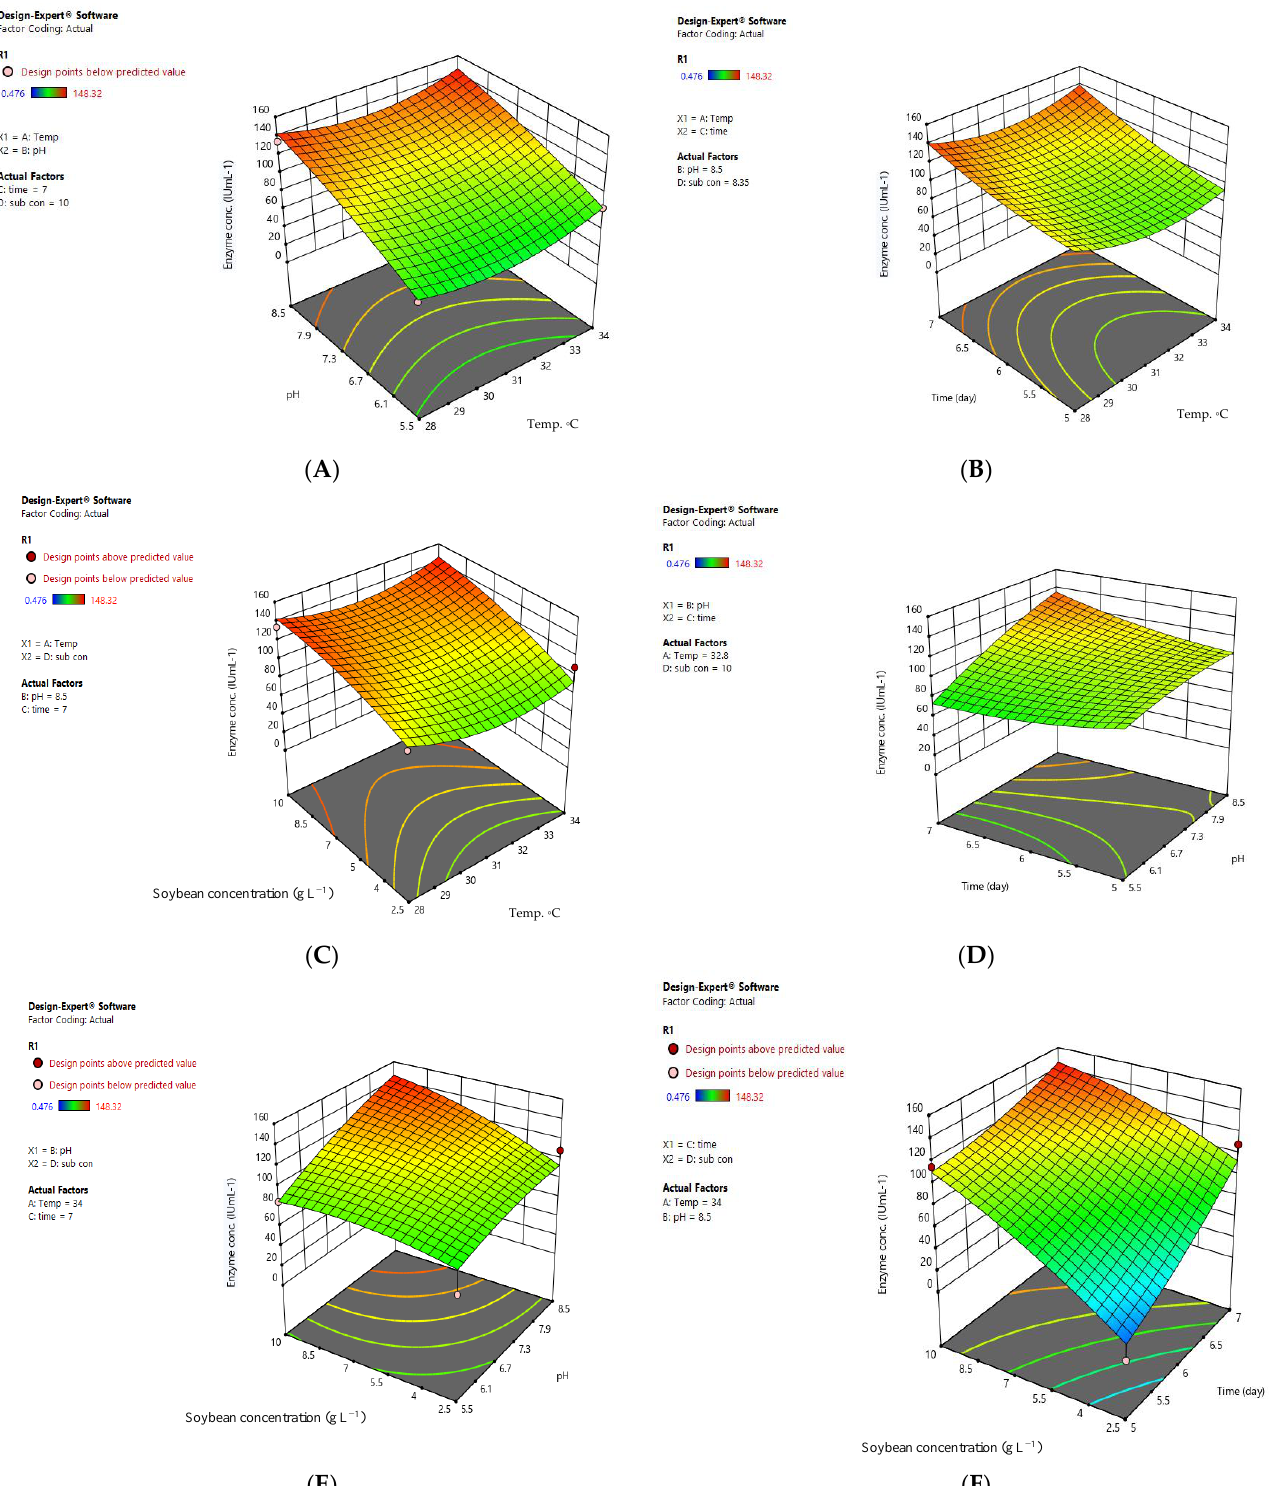
Figure 2. Interaction between independent factors and their effects on L-asparaginase production by A. arenarioides EAN603. Interaction between pH and Temperature ( A ); Interaction between time and Temperature ( B ); Interaction between Soybean concentration and Temperature ( C ); Interaction between pH and time ( D ); Interaction between pH and Soybean concentration ( E ); Interaction between time and Soybean concentration ( F